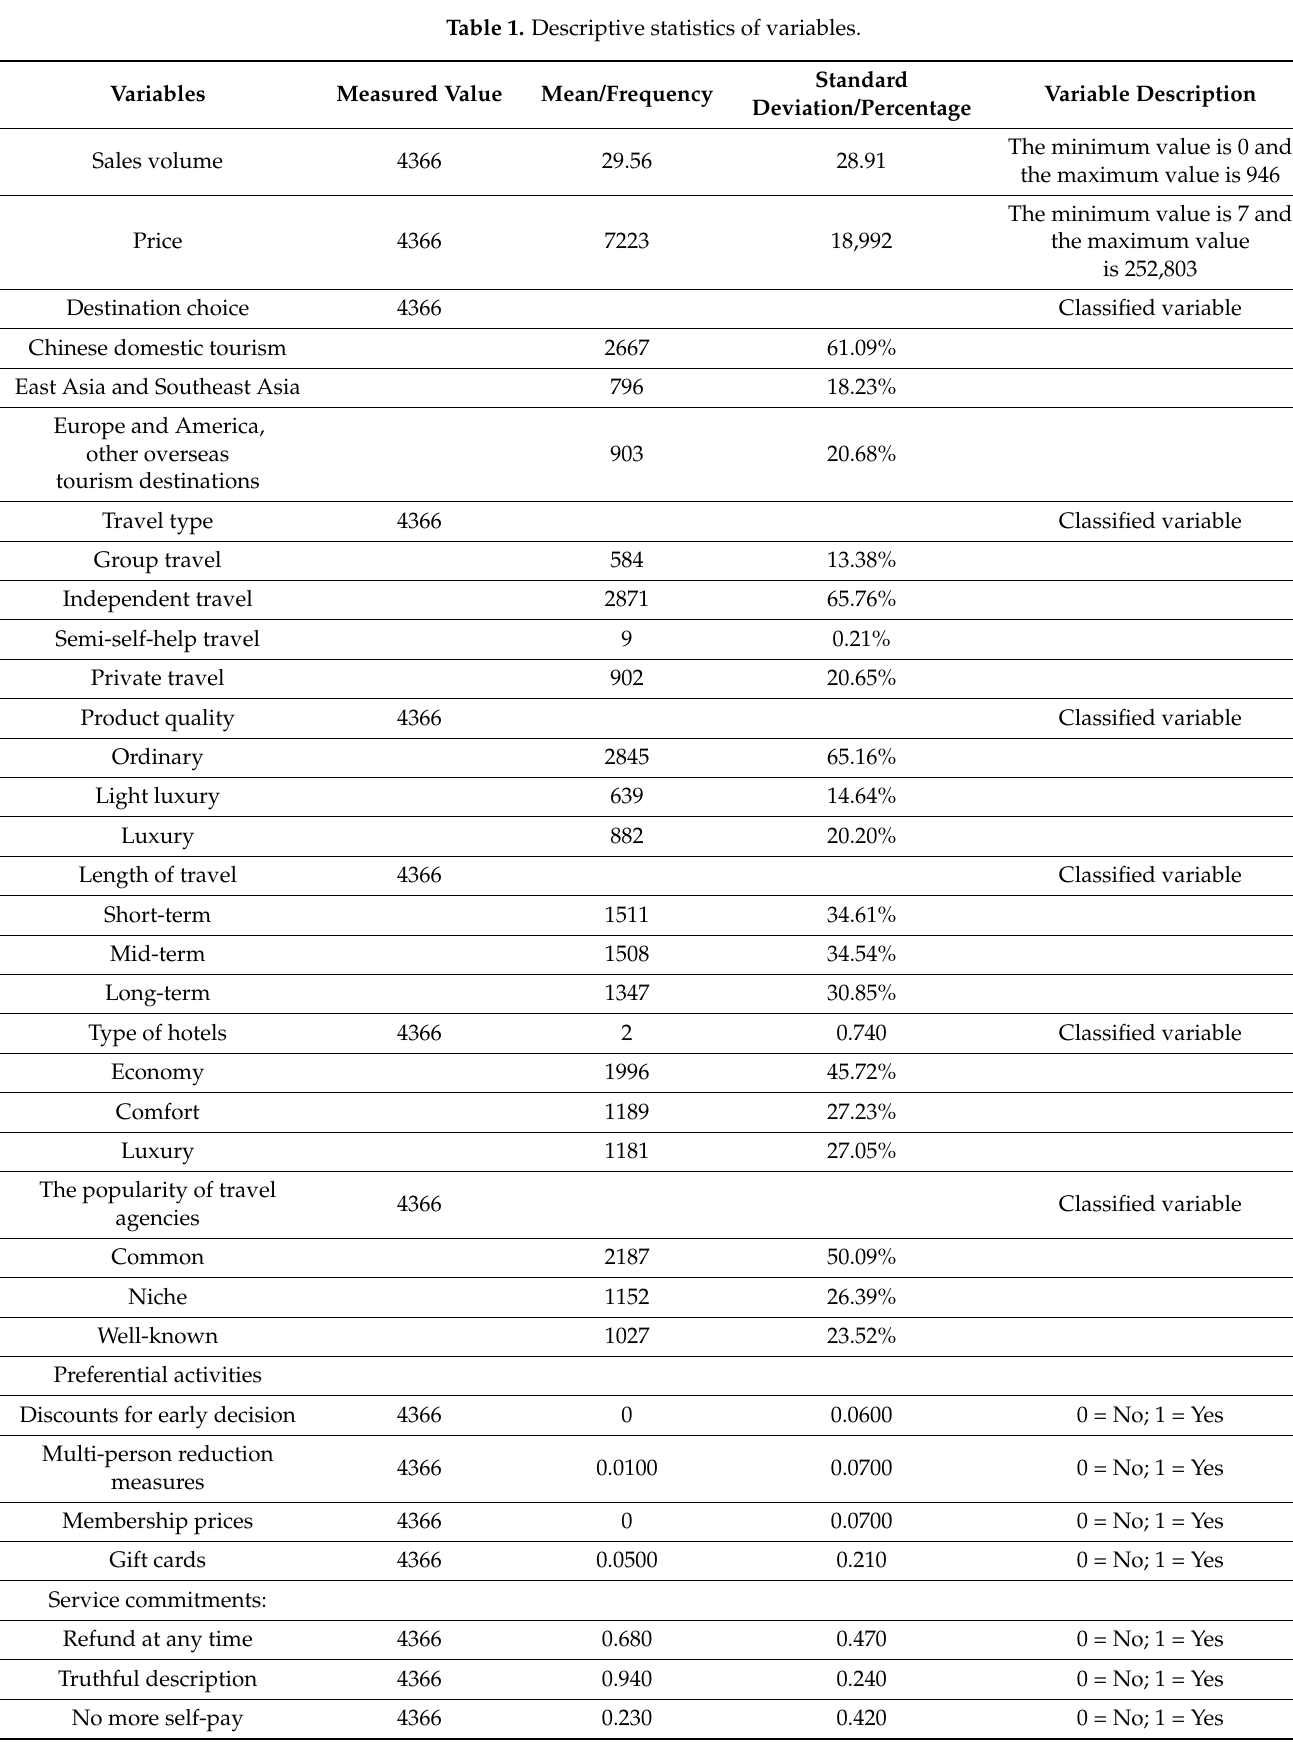
Table 1. Descriptive statistics of